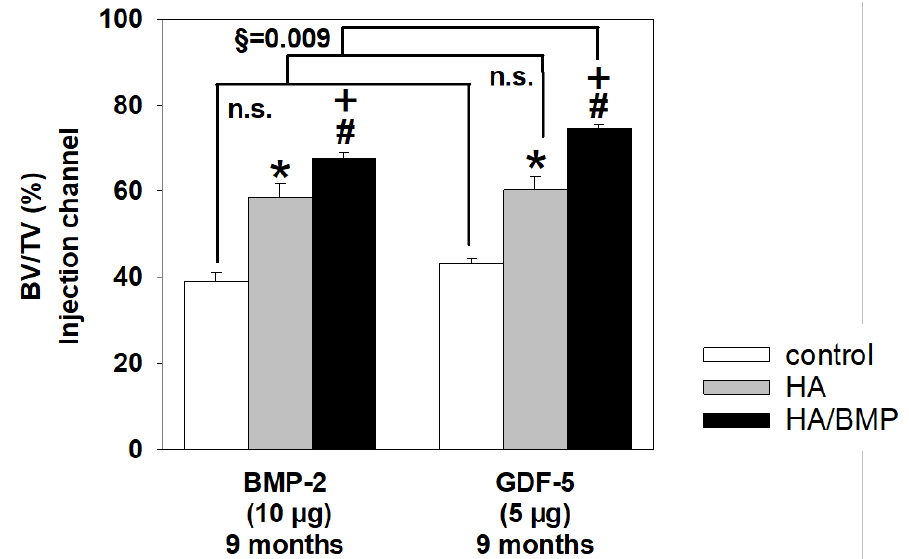
Figure 7. Increase of bone volume (%) in paraffin sections of lumbar vertebral bodies (L3 = control; L4 = HA/BMP; L5 = HA) of selected BMP-2 and GDF-5 groups in the vicinity of the injection channel. n.s. = not significant; p ≤ 0.05 Wilcoxon test, * for HA compared to non-injected control; # for HA/BMP compared to non-injected control; and + for HA/BMP compared to HA; brackets above the bars indicate the direct statistical comparison of the respective vertebral bodies in the BMP-2 and GDF-5 groups (§ p ≤ 0.01 U -test).